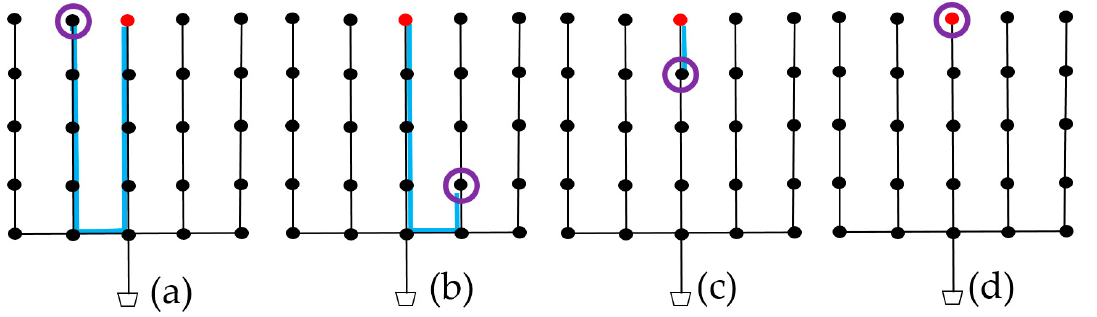
Figure 9. Leakage locations (purple circles) in network A in reference to the open fire hydrant H1 (red dots) taking into account different quantities of monitoring points: ( a ) monitoring flow meter q0 and pressure sensor p0 at the border of the network; ( b ) including one additional network pressure logger (p1); ( c ) including two network pressure loggers (p1 and p2); and ( d ): including three network pressure loggers (p1, p2, and p3). Table 2. Calculated length of the error (m) and total pipe length, number of loops, and fractal dimensions for all A – L networks.